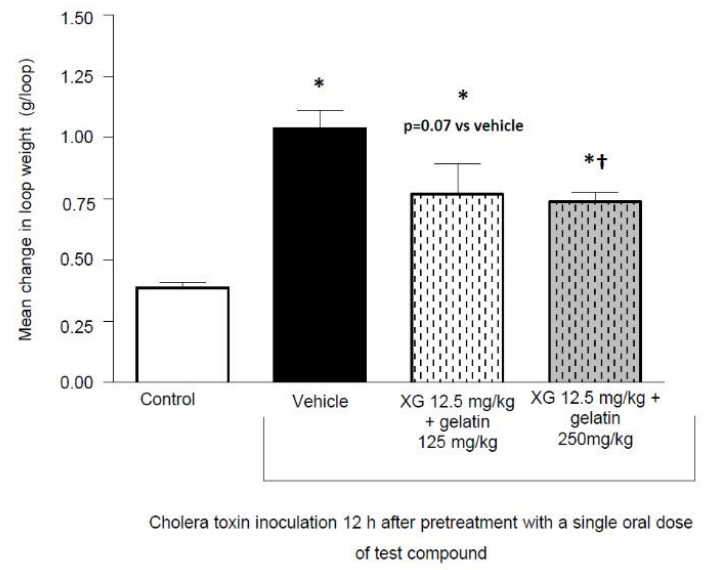
Figure 5. Pretreatment with single-dose oral xyloglucan 12.5 mg/kg + gelatin 250 mg/kg 12 h prior to cholera toxin (CT) inoculation significantly attenuated CT-induced intra-loop water secretion in isolated jejunal loops of anesthetized rats ( n = 8/group). * p < 0.05 vs. control, † p < 0.05 vs. vehicle.